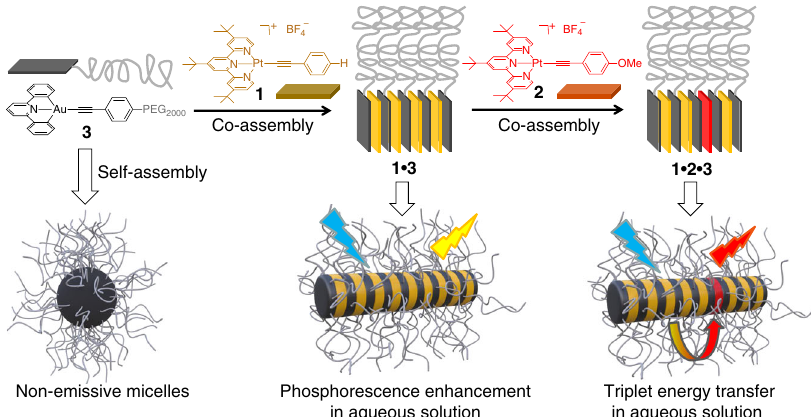
Fig. 1 Molecular structures design and aqueous light-harvesting applications. Schematic representation for the phosphorescent enhancement and triplet energy transfer of platinum(II) complexes 1 ‒ 2 in aqueous environment by employing the compartmentalized compound